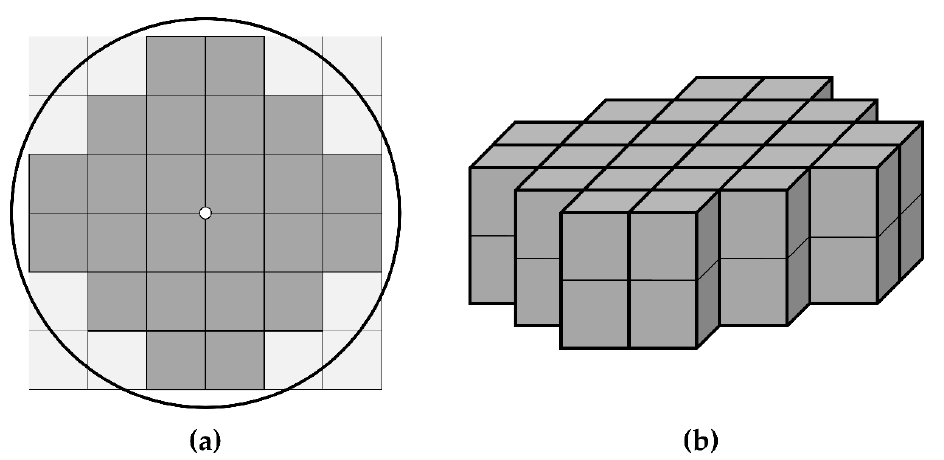
Figure 3. ( a ) 2-dimensional distribution of the voxels in a plot (dark grey) in a circular plot of radius five meters (black circle). The size of each voxel was 1.5 m × 1.5 m. ( b ) 3-dimensional distribution of the same voxels. The size of each voxel was 1.5 m × 1.5 m × 1.5 m or 1.5 m × 1.5 m × 3